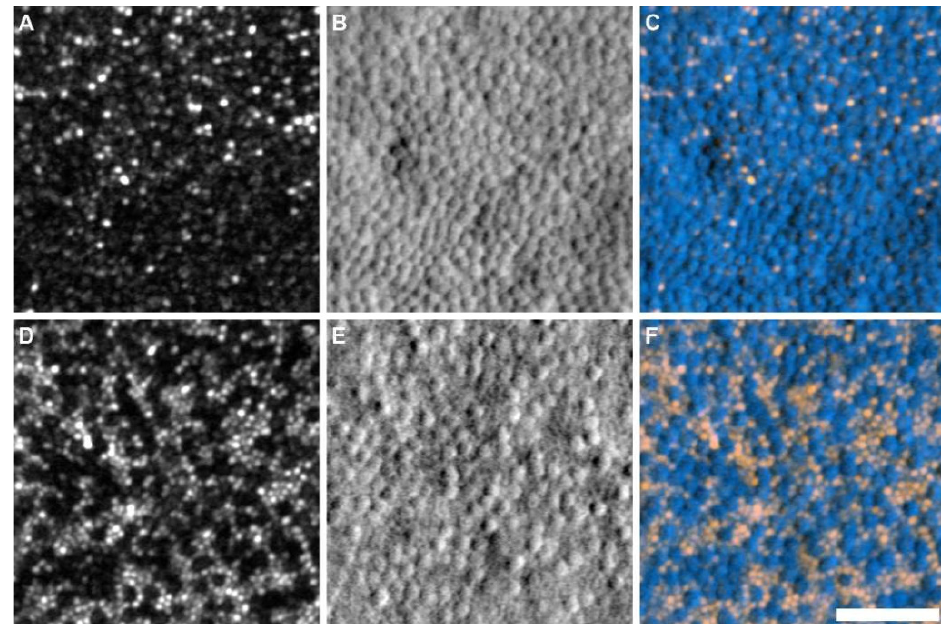
Figure 6. Confocal and split-detector AO-SLO images of the photoreceptor mosaic in a patient with achromatopsia at 0.4° and 2° from fixation. ( A , D ) Confocal images; ( B , E ) split-detector images; and ( C , F ) color-merged images, where the confocal image was displayed in orange, and split-detector image was shown in blue. Note the 1:1 correspondence between the dark cones in the confocal images and the inner segments in the split-detector images, highlighted by the pseudocolor images ( C , F ). Scale bar: 50 μ m (Reprinted with permission from Ref. [77]. Copyright 2014, The Association for Research in Vision and Ophthalmology, Inc.).